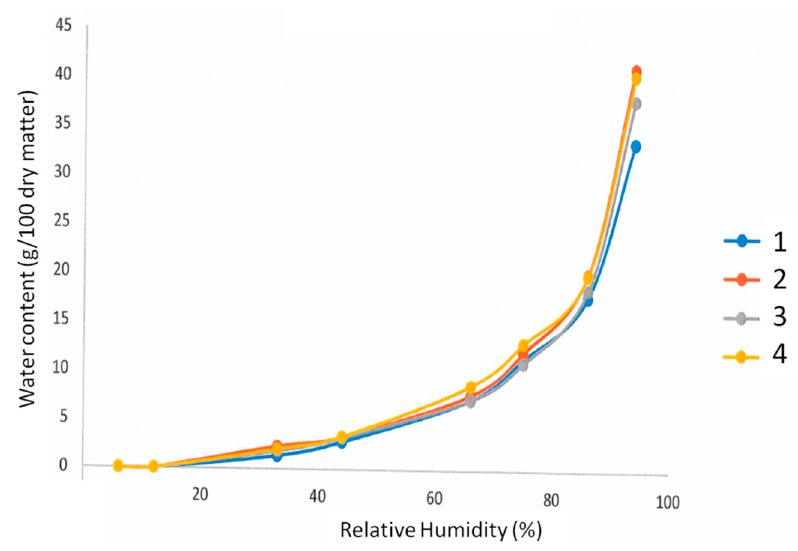
Figure 5. Water vapor adsorption isotherm of bioplastic films samples 1–4.